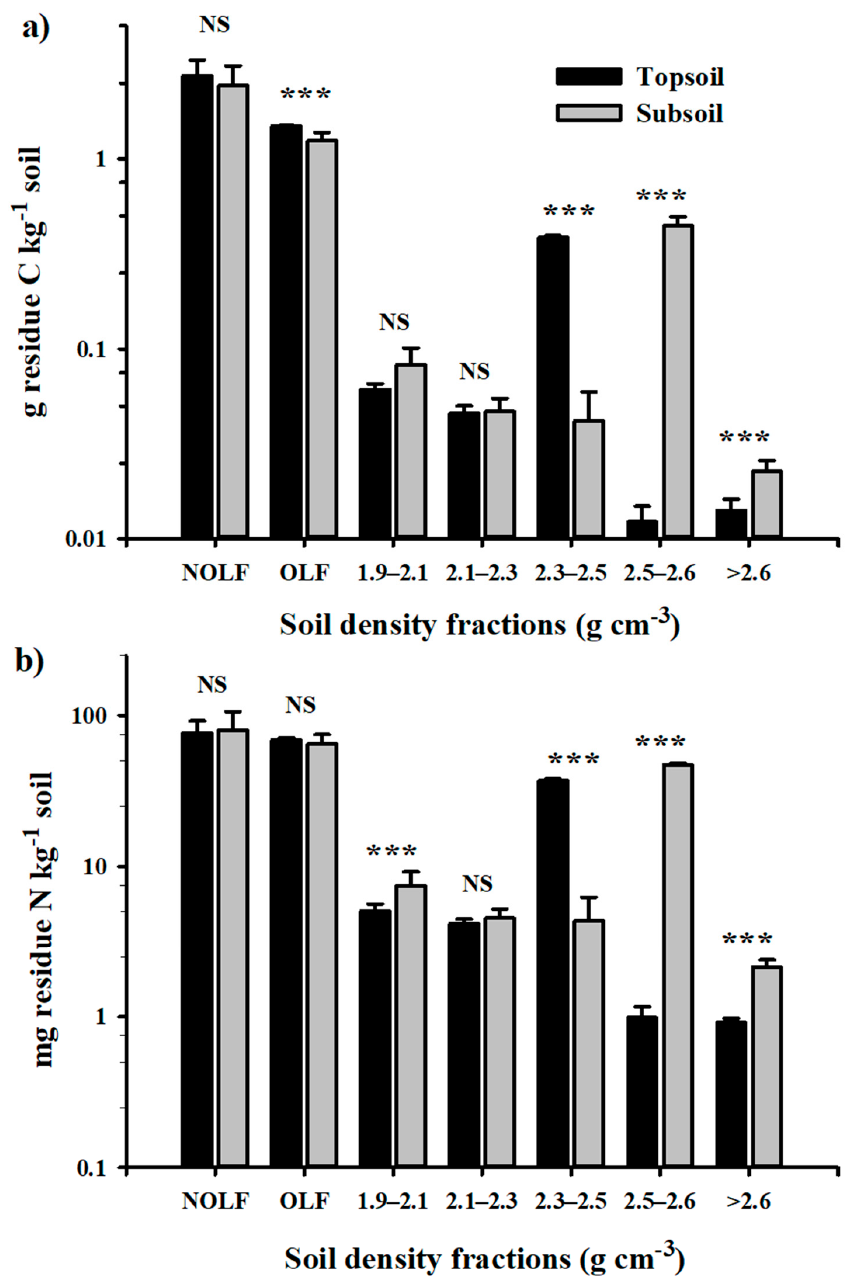
Figure 4. Concentrations of ( a ) residue C and ( b ) residue N in density fractions in topsoil (0–20 cm) and subsoil (30–70 cm) (Equation (5)) after 51 d of incubation with 10 g C kg − 1 of 13 C- 15 N-labelled corn residues. Error bars are standard deviation of the mean. NOFL, non-occluded light fraction ( ρ < 1.9); OFL, occluded light fraction ( ρ < 1.9). Within soil density fractions, NS indicates no significant difference and *, **, and *** indicate significant difference between topsoil and subsoil at p < 0.05, 0.01, and 0.001, respectively (LSD test). The y -axis is on a logarithmic scale.